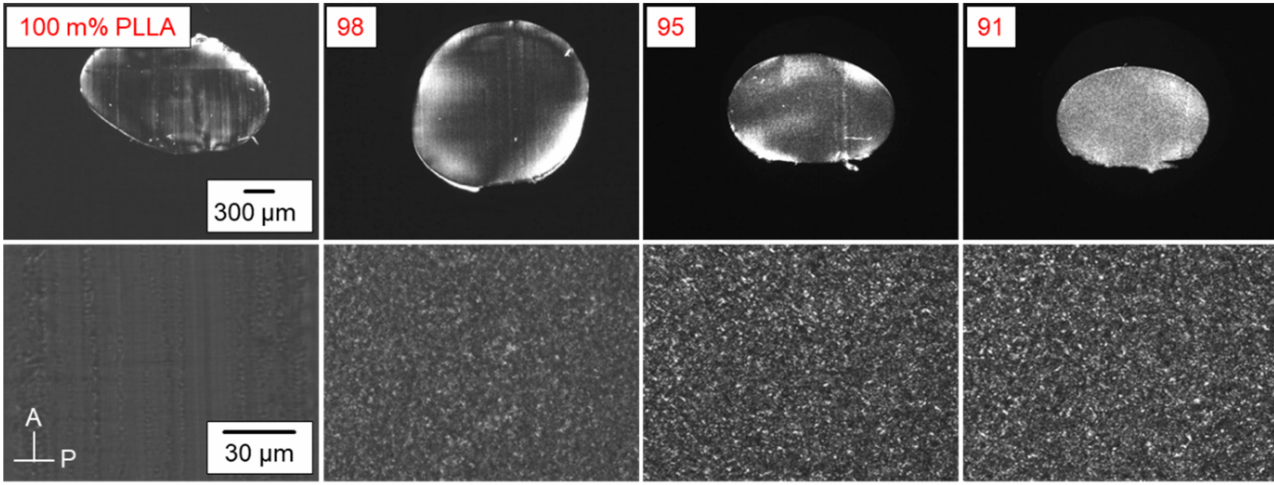
Figure 8. POM images of PLLA/IR3535 extrudates stored at room temperature for 17 days and then annealed at 60 ◦ C for 3–4 weeks.